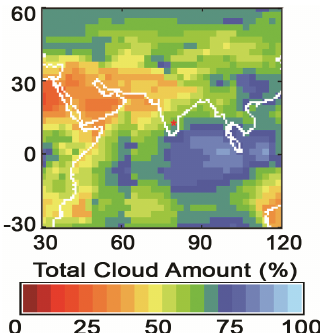
Figure 1. Average cloud cover (in terms of % of occurrence) over India. The cloud cover data are generated by International Satellite Cloud Climatology Project (ISCCP) from the day and night mea- surements of polar orbiting satellites made during 1983–2009. The star denotes the location of Gadanki (13.45 ◦ N, 79.18 ◦ E). (Cour- tesy: http://isccp.giss.nasa.gov; reference for ISCCP data product descriptions: Rassow and Schiffer,